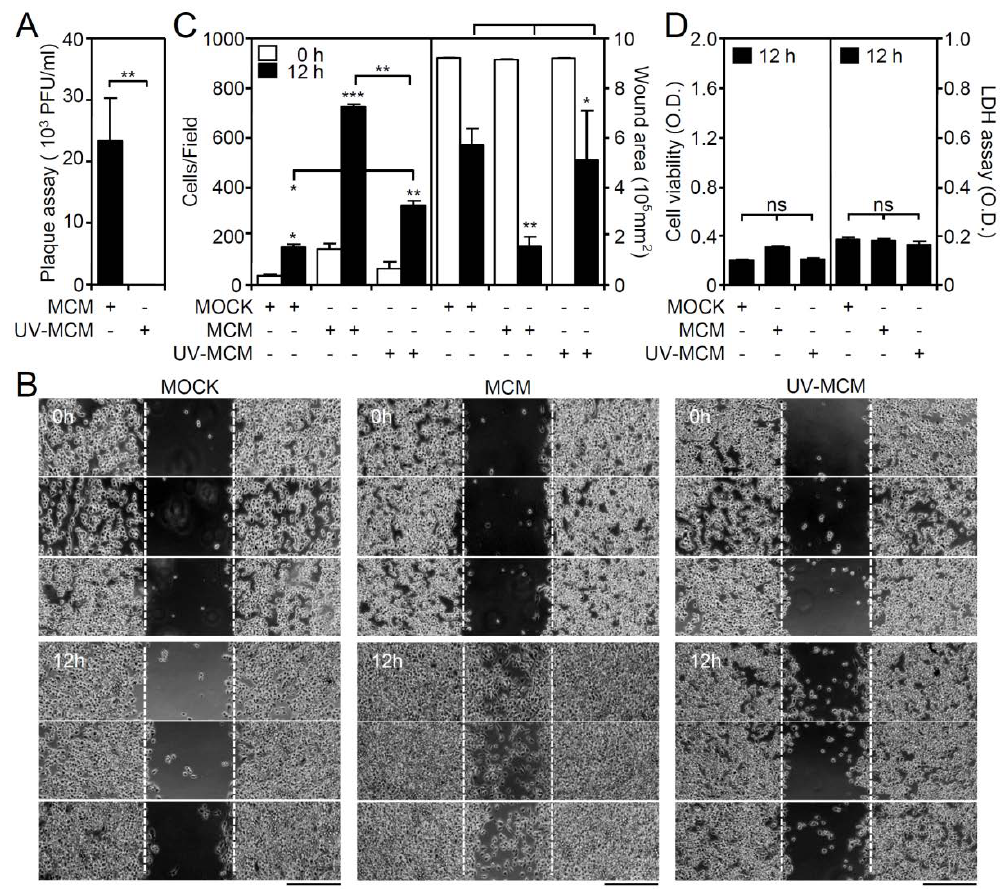
Figure 1. Microglial conditioned medium (MCM) collected from dengue virus (DENV)-infected BV2 microglia stimulates cell migration. BV2 cells were inoculated with DENV 2 (MOI = 50) for 12 h, and the MCM was collected in the absence or presence of UV irradiation. ( A ) Plaque assay confirmation of viral release. ( B ) A wound-healing assay performed in triplicate showed cell migration. Scale bar, 200 μm. ( C ) Image analysis was performed using ImageJ based on the number of migrating cells and the changes in the wound area. The quantitative data are depicted as the means ± SD. ( D ) MTT and LDH assays showed the cell viability and cytotoxicity, respectively, of BV2 cells inoculated with MCM and UV-inactivated MCM. The quantitative data (optical density, O.D.) are shown as the means ± SD from three independent experiments. * p < 0.05, ** p < 0.01, and *** p < 0.001. ns, not significant.